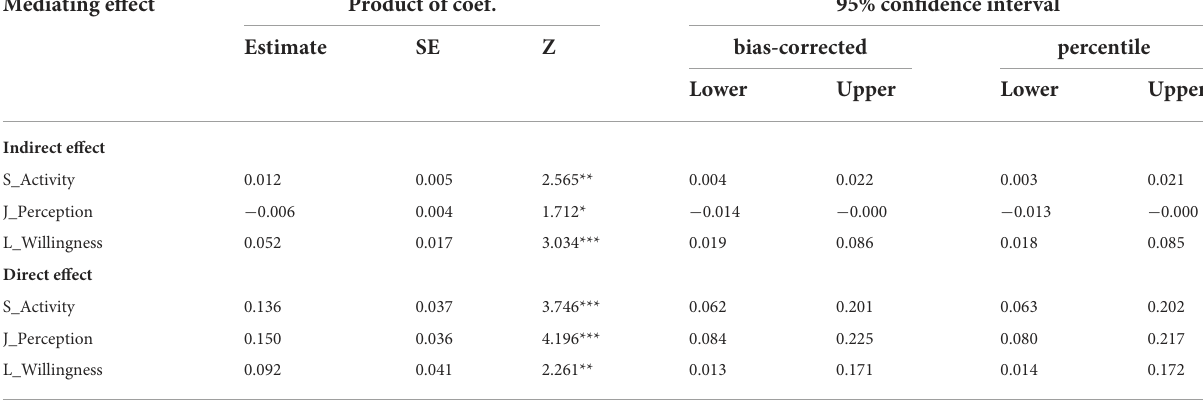
TABLE 6 Mediation effect test.